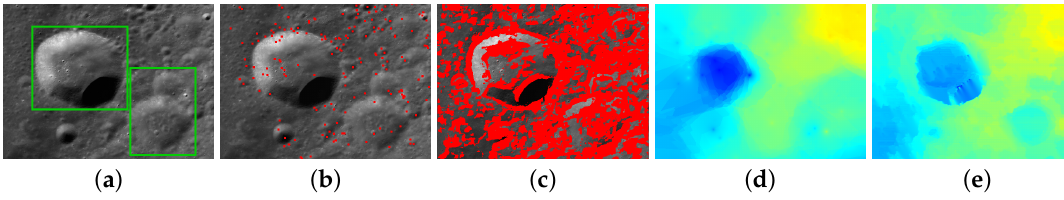
Figure 10. Image matching using SIFT and SIFT + normalized cross-correlation (NCC). ( a ) The original CCD images; ( b , c ) the features (red dots) detected by SIFT and SIFT + NCC, respectively; ( d , e ) the reconstructed altitude maps based on ( b ) and ( c ),